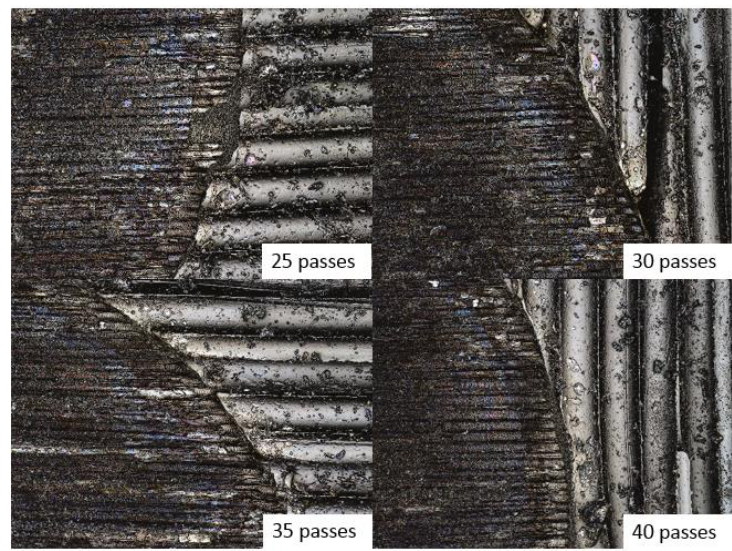
Figure 9. Effect of number of passes on HAZ in a spiral drilling cycle.